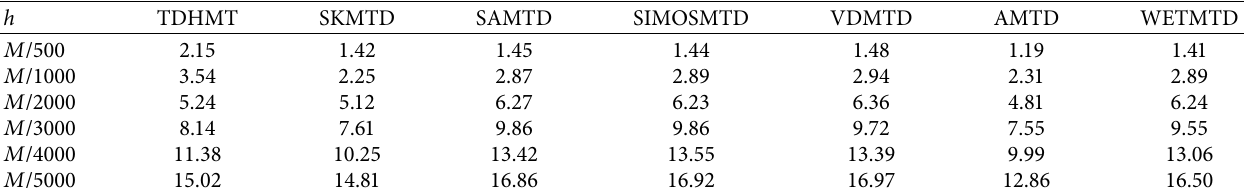
Table 2: Comparison of the CPU time of TDHMT with the CPU time of other existing methods, namely, SKMTD, SAMTD, SIMOSMTD, VDMTD, AMTD, and WETMTD for Example 1.